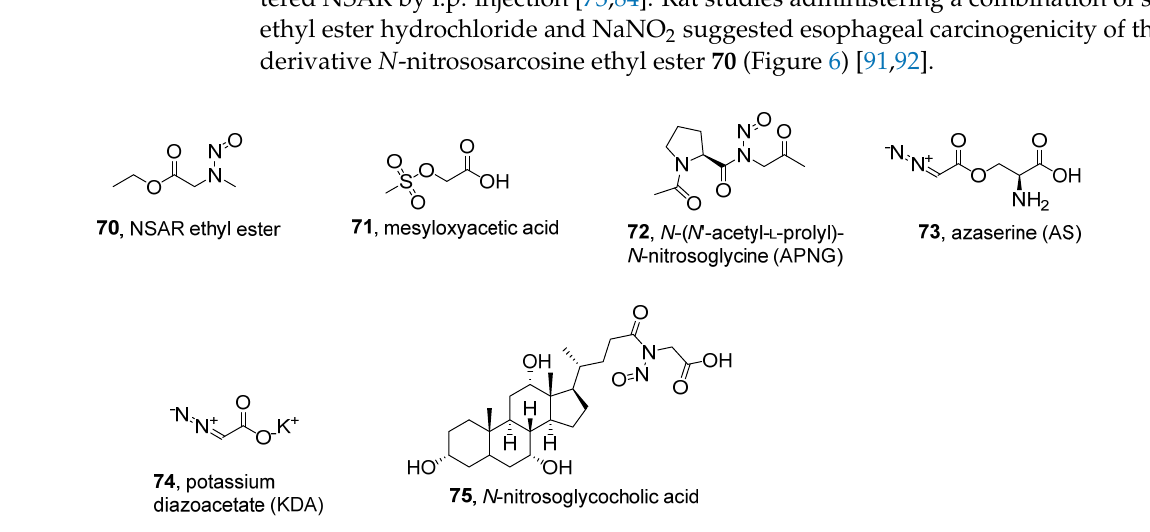
Figure 6. Structures of agents that carboxymethylate